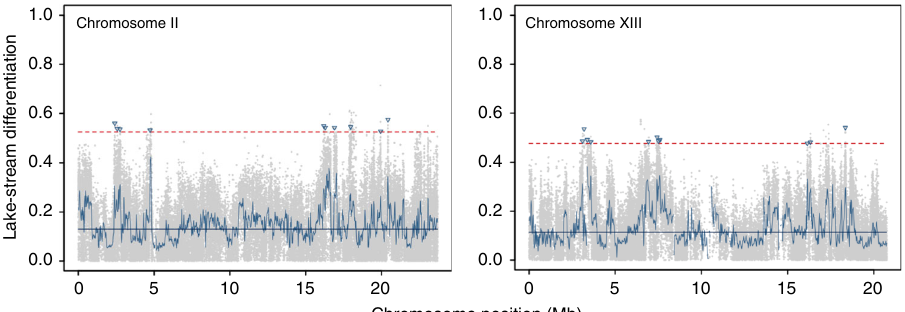
Fig. 2 Genomic differentiation between the natural lake and stream populations. Pro fi les of the absolute allele frequency difference (AFD) along two exemplary chromosomes, with the gray dots representing individual single-nucleotide polymorphisms (SNPs) and the solid black lines indicating chromosome-speci fi c median values. The blue curves show differentiation smoothed by averaging AFD across SNPs for 40 kb sliding windows with 20 kb overlap. The dashed red lines give the upper 0.1 percentile of the chromosome-speci fi c AFD distribution used as a threshold for delimiting candidate genome regions under divergent lake-stream selection. The triangles identify a subset of the 126 total genome-wide SNPs eventually used as experimental target SNPs representing the independent candidate regions. Note that some high-differentiation regions are not tagged by a target SNP, or the target SNP is not the one with the highest AFD value, because SNPs in these regions failed to satisfy quality fi lters in the